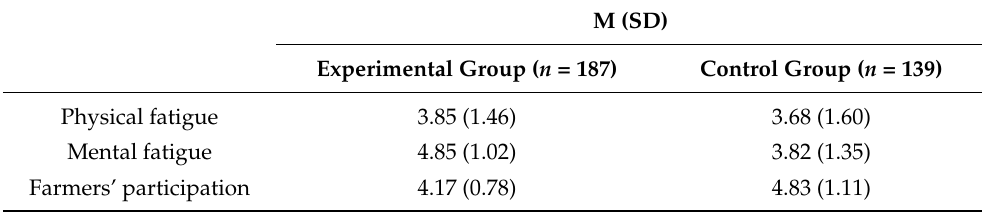
Table 4. Descriptive